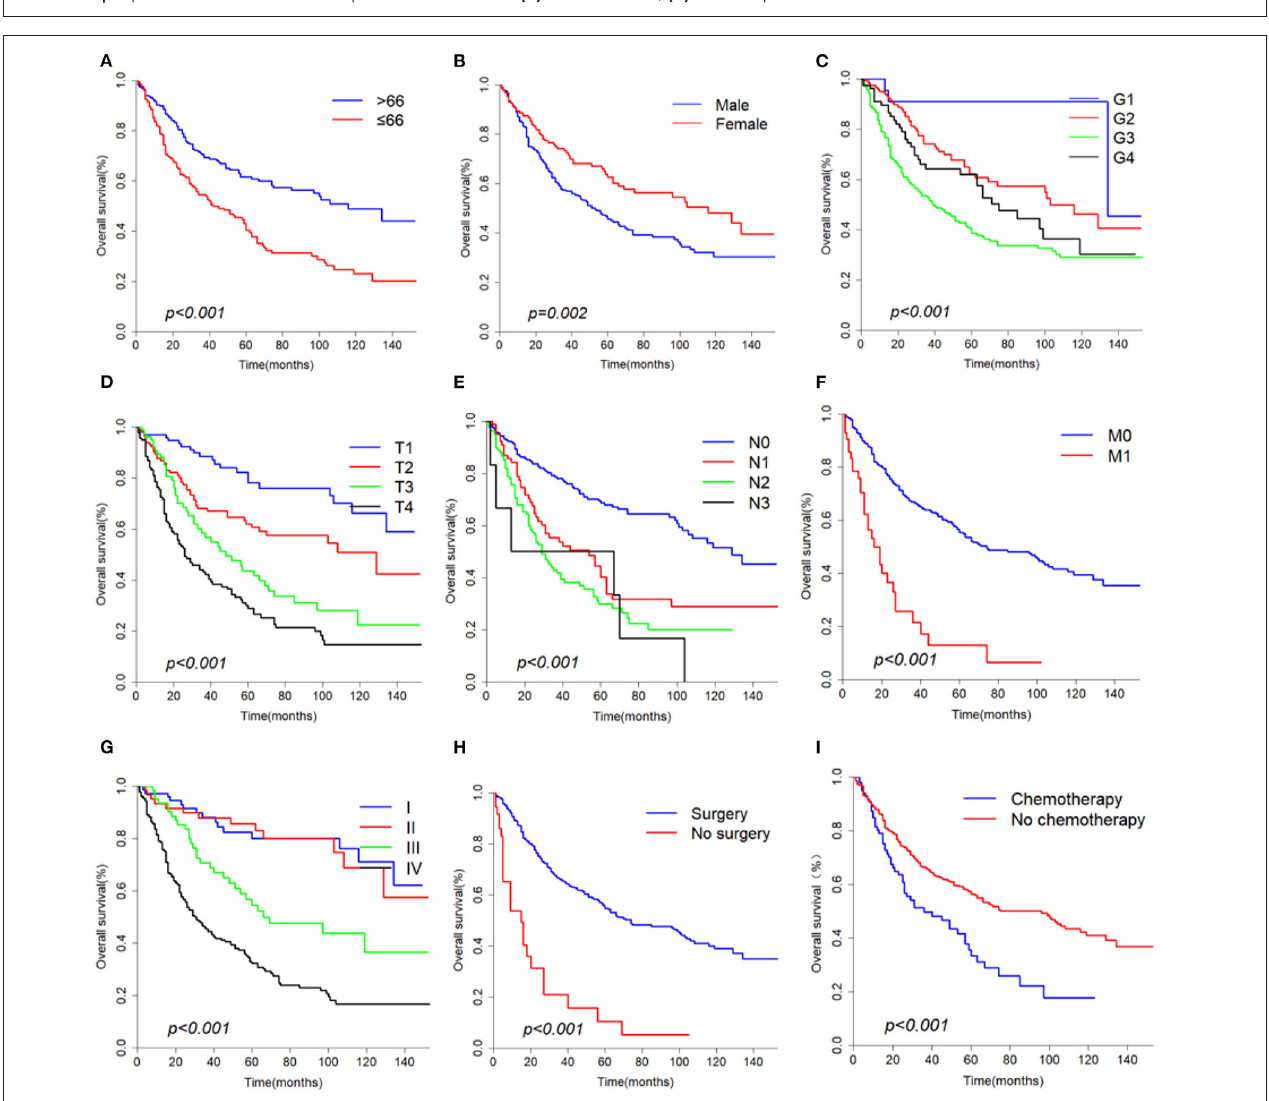
FIGURE 3 | Overall survival curves according to (A) Age, (B) Gender, (C) Grade, (D) T classification, (E) N classification, (F) M classification, (G) Stage, (H) Surgery, (I) Chemotherapy.